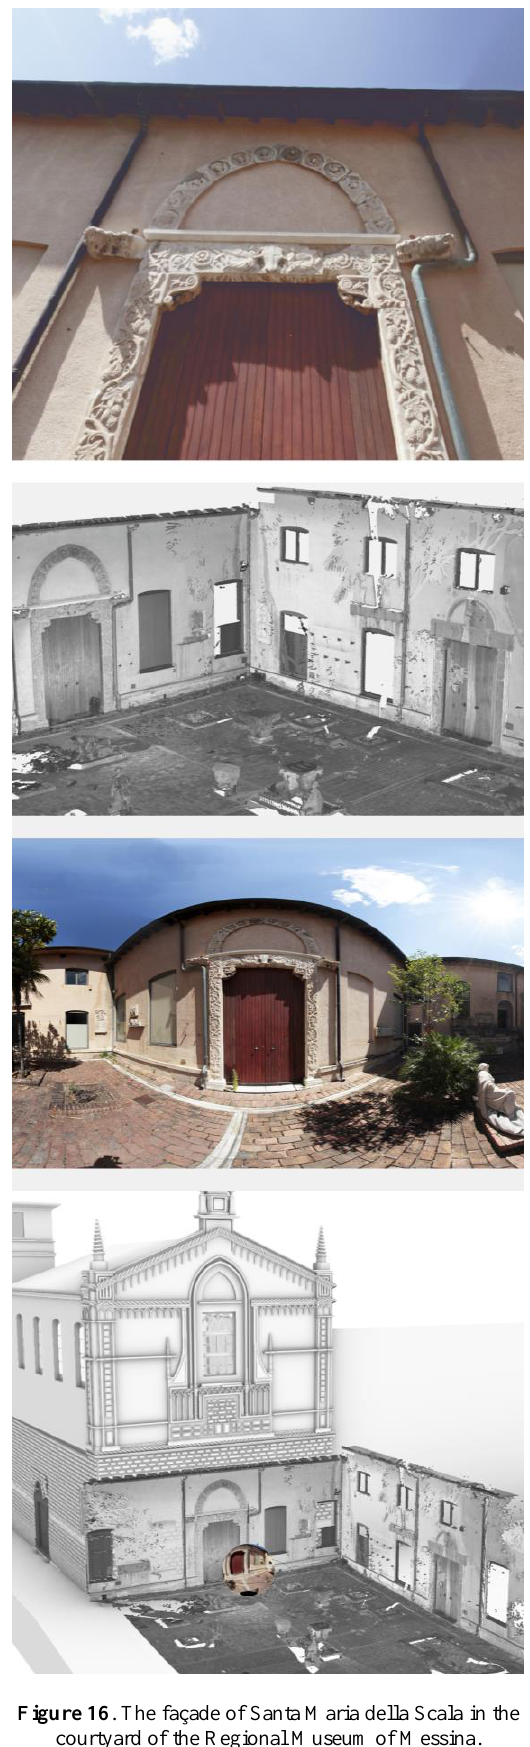
Figure 16 . The façade of Santa Maria della Scala in the courtyard of the Regional Museum of